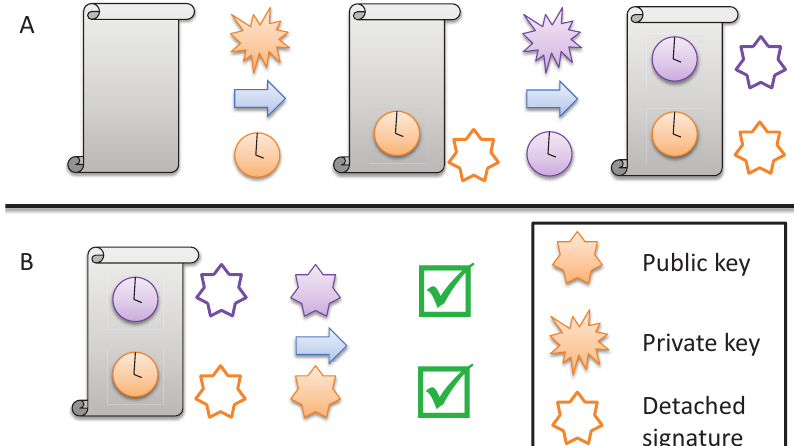
Figure 2: Digital signatures require a pair of asymmetric keys that is generated by the system for each user. A: The author uses his/her private key, his/her password and a timestamp to sign a note. A second signature is added by the supervisor or a colleague based on his/her private key, the current timestamp and the timestamp of the author. The result is a detached signature for the author and the supervisor, respectively. B: The public keys of the author and the supervisor, together with the original note and the original timestamps can be used to validate the